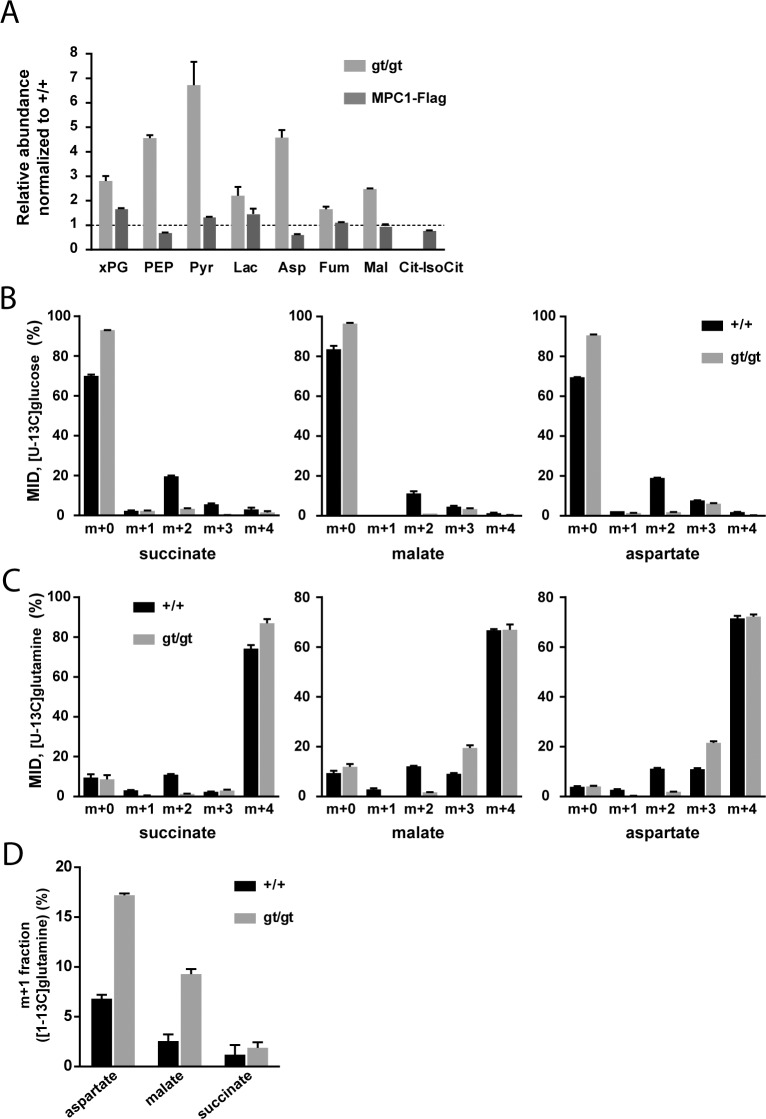
MPC deficiency alters the flux of glycolytic pyruvate into the TCA cycle and is compensated by increased glutamine-driven anaplerosis and reductive TCA cycle.(A) The steady-state abundance relative to MPC1+/+ (dotted line) of the indicated metabolites in MPC1gt/gt (light grey bars) and MPC1-Flag rescued MEFs (dark grey bars) was determined by targeted metabolomics. (B,C) Mass isotopomer distribution (MID) of succinate, malate and aspartate in MPC1+/+ (black bars) and MPC1gt/gt (grey bars) MEFs cultured in the presence of (B) [U-13C]glucose or (C) [U-13C]glutamine. (D) m+1 fraction of aspartate, malate and succinate in MPC1+/+ (black bars) and MPC1gt/gt (grey bars) MEFs cultured in the presence of [1-13C]glutamine. xPG: 2-/3-phosphoglycerate; PEP: phosphoenolpyruvate; Pyr: pyruvate; Lac: lactate; Asp: aspartate; Fum: fumarate; Mal: malate; Cit-IsoCit: citrate-isocitrate.